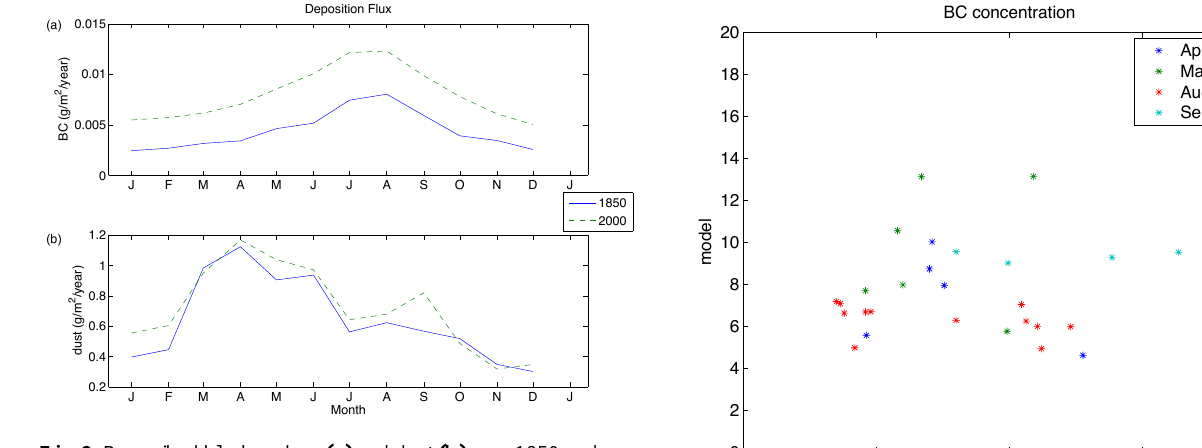
Fig. 2. Prescribed black carbon (a) and dust (b) year 1850 and year 2000 deposition fluxes (gm − 2 yr − 1 ) as a function of month for lat- itudes North of 60 ◦ N.